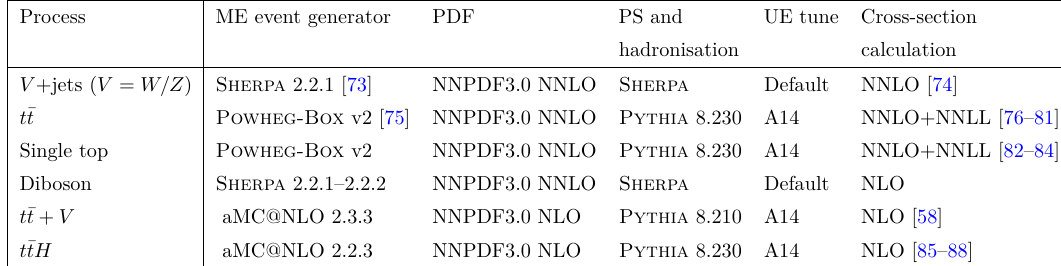
Table 1 . The SM background MC simulation samples used in this paper. Generator, PDF set, parton shower, tune used for the underlying event (UE), and order in α used for yield normalisation, are shown for each process